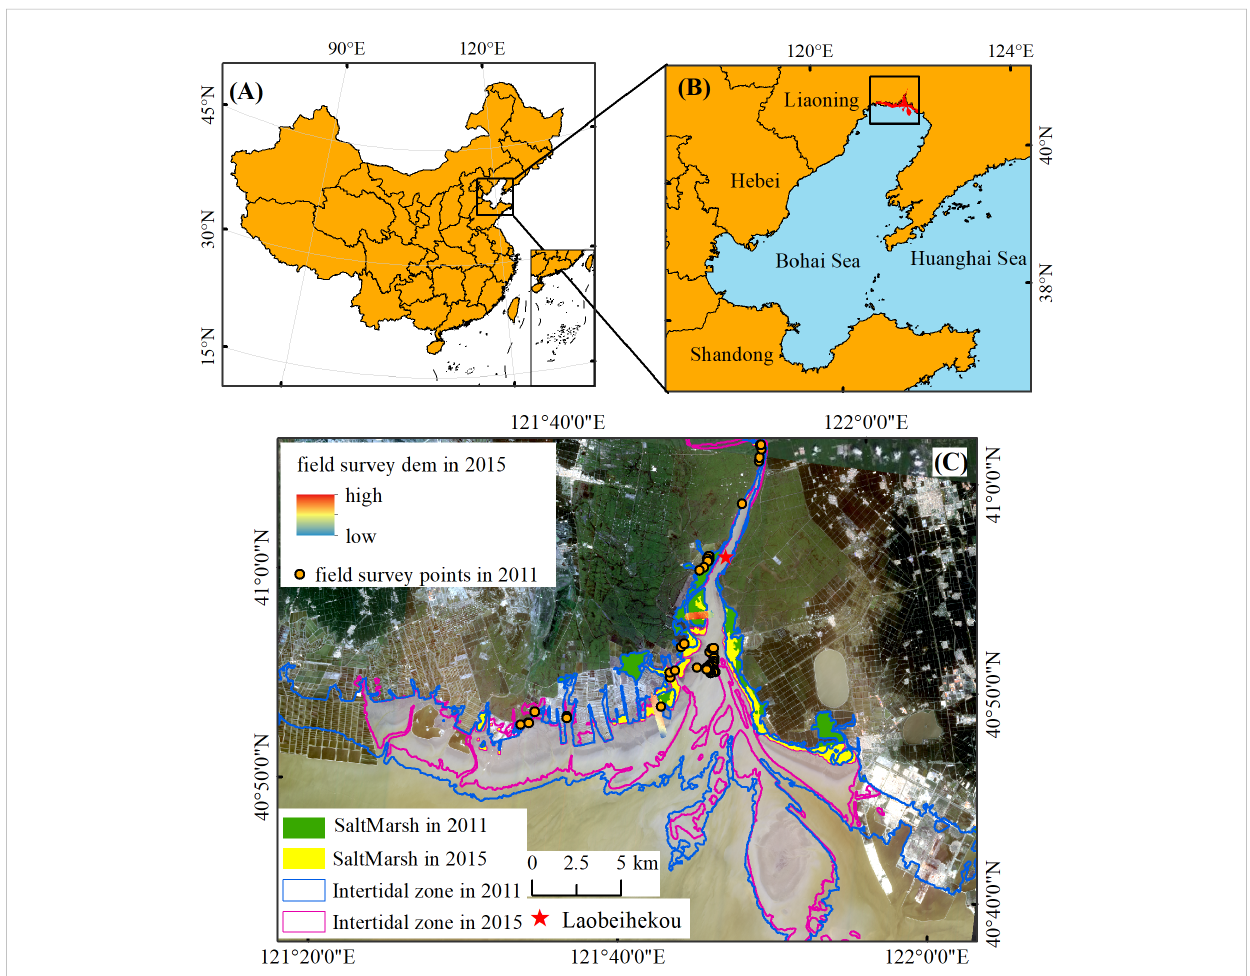
FIGURE 1 The location of Liaohe estuary (A, B) and the range of intertidal features in 2011 and 2015 (C) . The red star refers to Laobeihekou Tidal Gauge Station. The background image was captured by the GaoFen satellite in 2020. The boundary of intertidal zones (the blue line for 2011 and the pink line for 2015) and the saltmarsh distribution (the green area for 2011 and yellow area for 2015) was derived from the “ Tidal Flats Dataset Covers Coastal Region in North of 18°N Latitude of China (1989-2020) (Hu et al.,